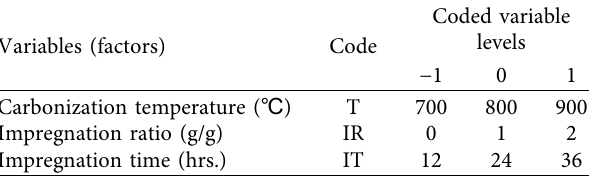
Table 1: Selected optimization